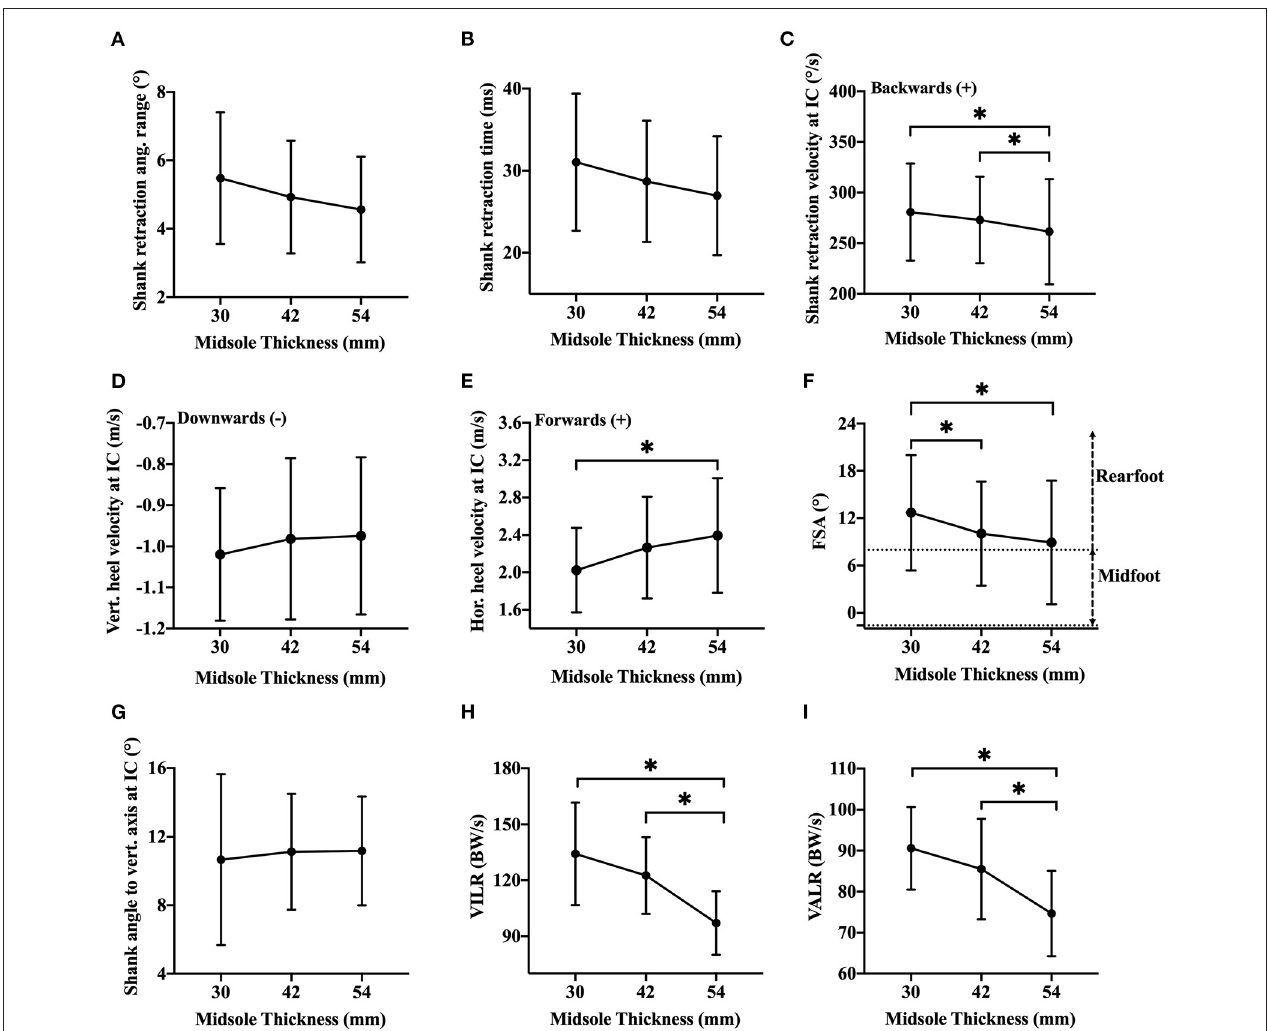
FIGURE 4 | Mean ± SD of shank retraction angular range prior to IC (A) ; shank retraction time prior to IC (B) ; shank retraction angular velocity at IC (C) ; vertical (D) and horizontal (E) heel velocity at IC; FSA (F) ; shank angle to vertical axis at IC (G) ; VILR (H) and VALR (I) in three shoe conditions, while * p <